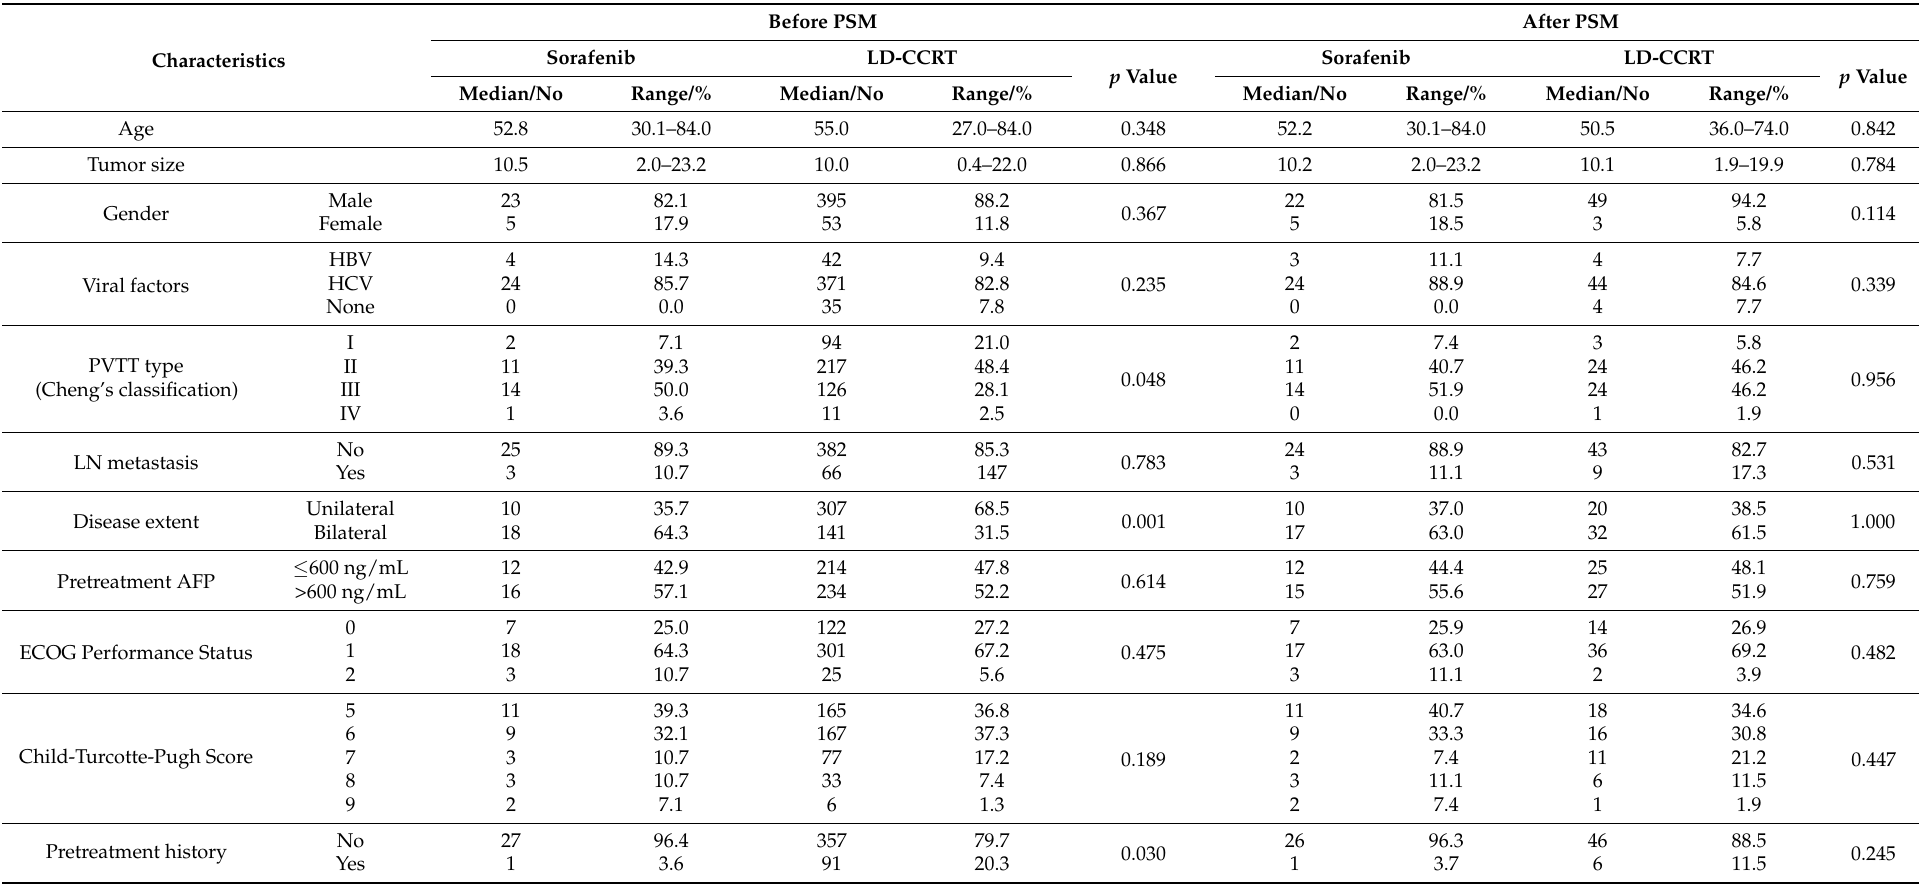
Table 1. Baseline characteristics of the sorafenib- and liver-directed concurrent chemoradiotherapy-treated groups before and after PSM.